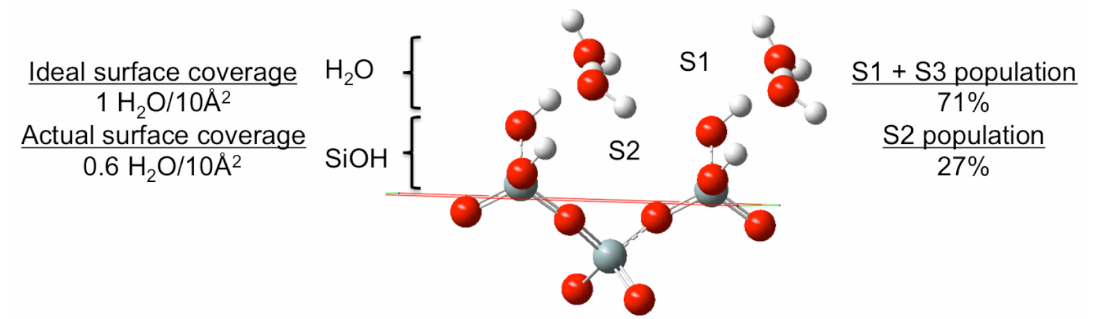
Figure 5. Identification of two of the three surface adsorption sites of H (reproduced with permission from the author). Site S3 is not at a fixed location and is thus not illustrated. Comparisons of the ideal and actual surface coverage values (waters with direct H-bonding interaction with surface –SiOH groups) are presented alongside the percentage of surface bound waters in sites S2 and the combined S1 + S3 sites (which cannot be distinguished using the H-bond